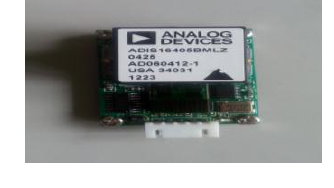
Figure 2. ADIS 16405.